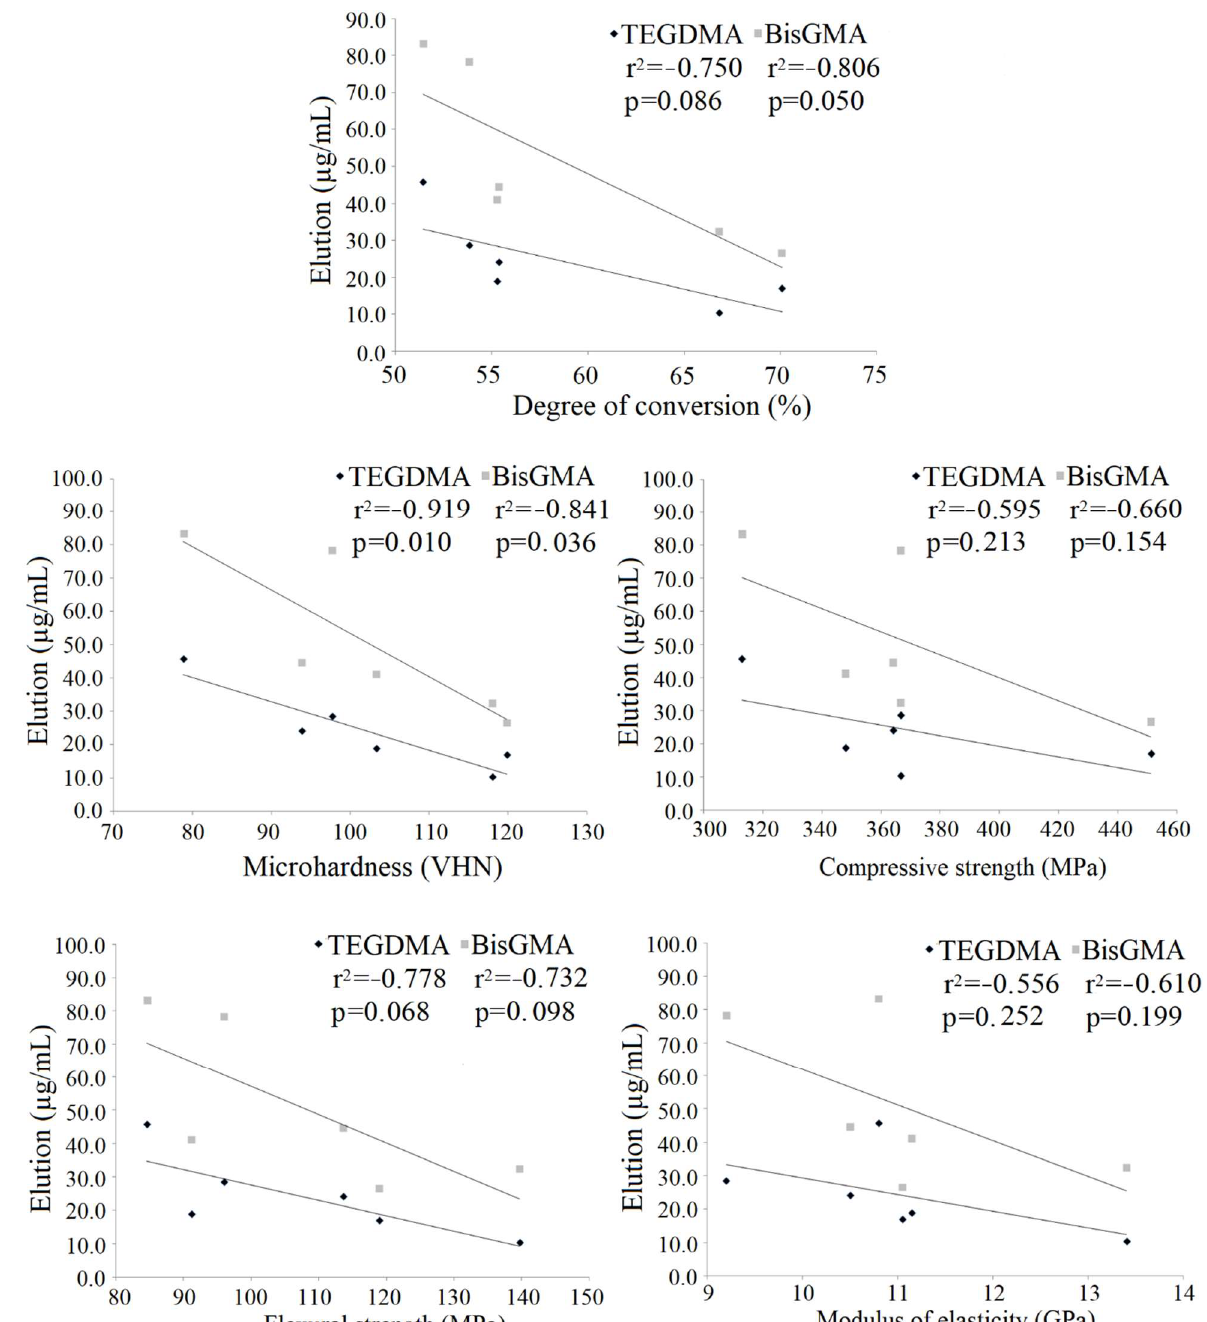
Figure 6. Correlation between monomer elution and the degree of conversion and between monomer elution and mechanical properties of core composites.